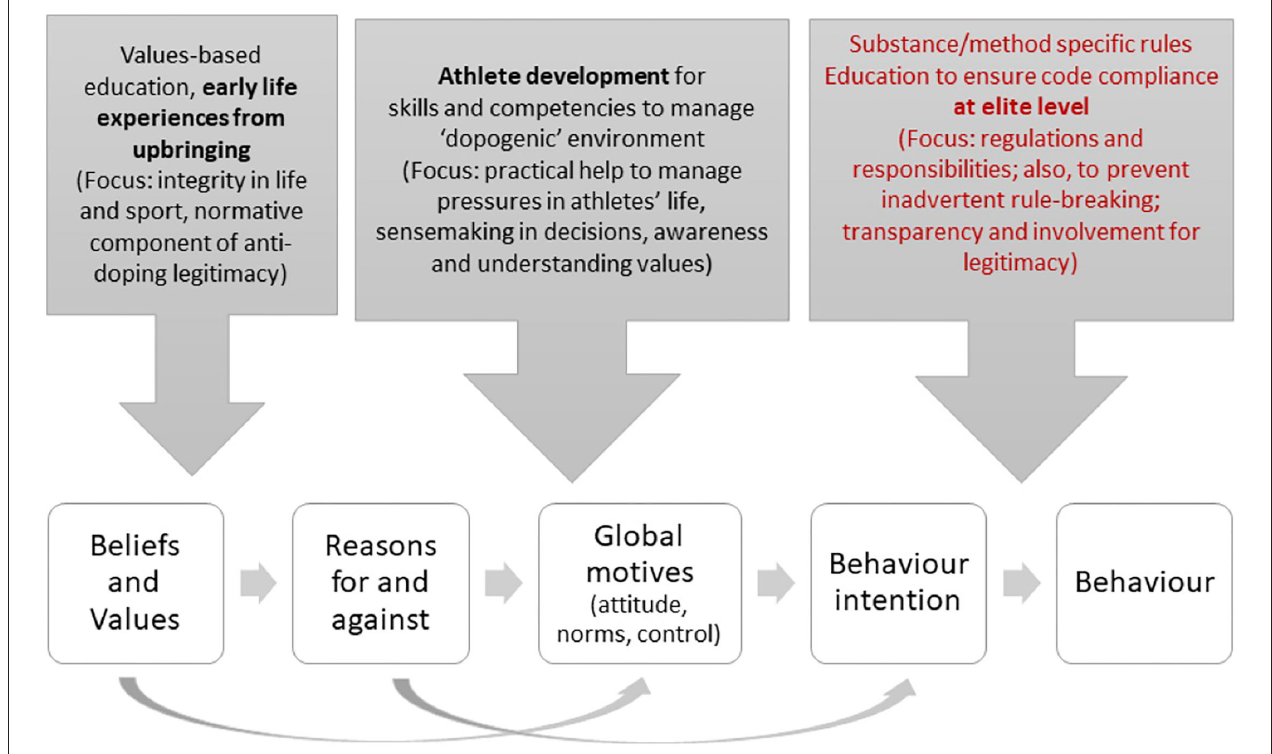
FIGURE 2 | Mapping educational components to decision making about doping.